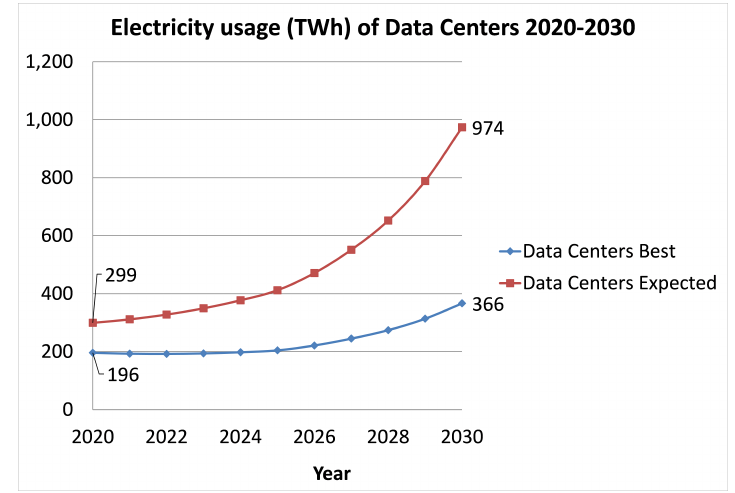
Figure 1. Trends for data centers 2020 to